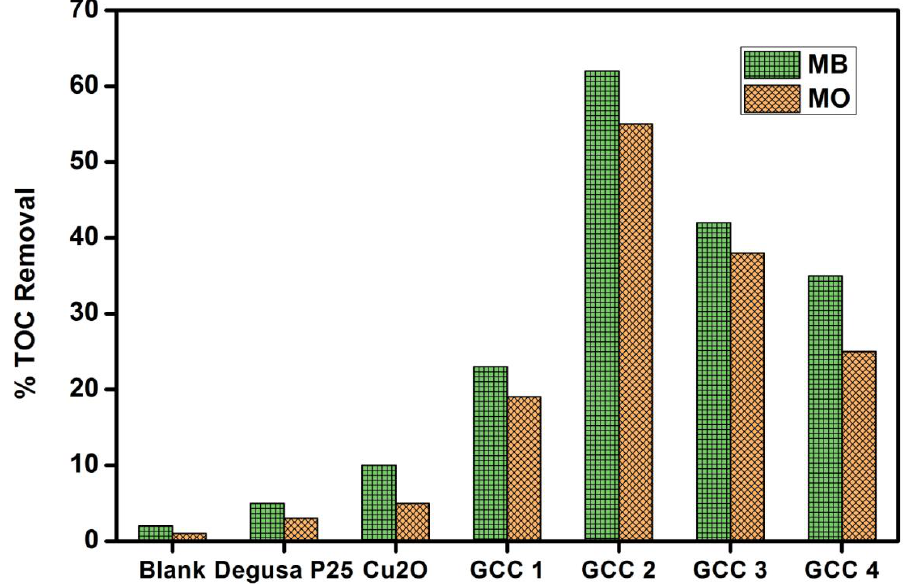
Figure 13. TOC removal profile for MB and MO dyes.